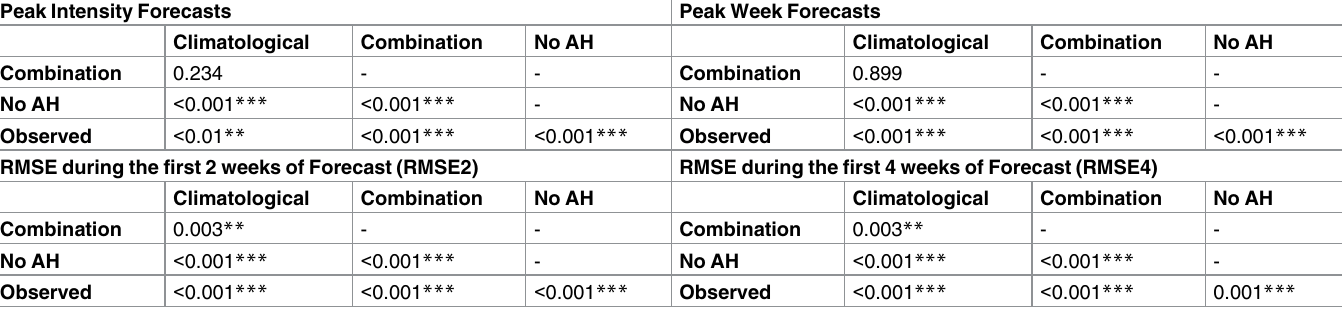
Table 2. Pairwise p-values derived from Nemenyi tests of the forecastranks shown in Table 1. Asterisks designate differences significantat p < 0.01 ( ** ) and p < 0.001( *** ). Peak Intensity Forecasts